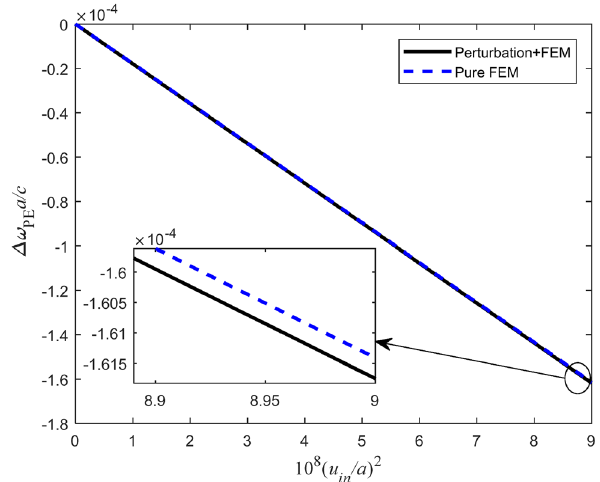
Figure 4: Normalized frequency shift of the optical modes ω 1 as a function of the acoustic input displacement level ( u in / a ) 2 at the acoustic normalized frequency of Ω a c 1.25492 1 l;SiO / = , which is 2 calculated by two methods.